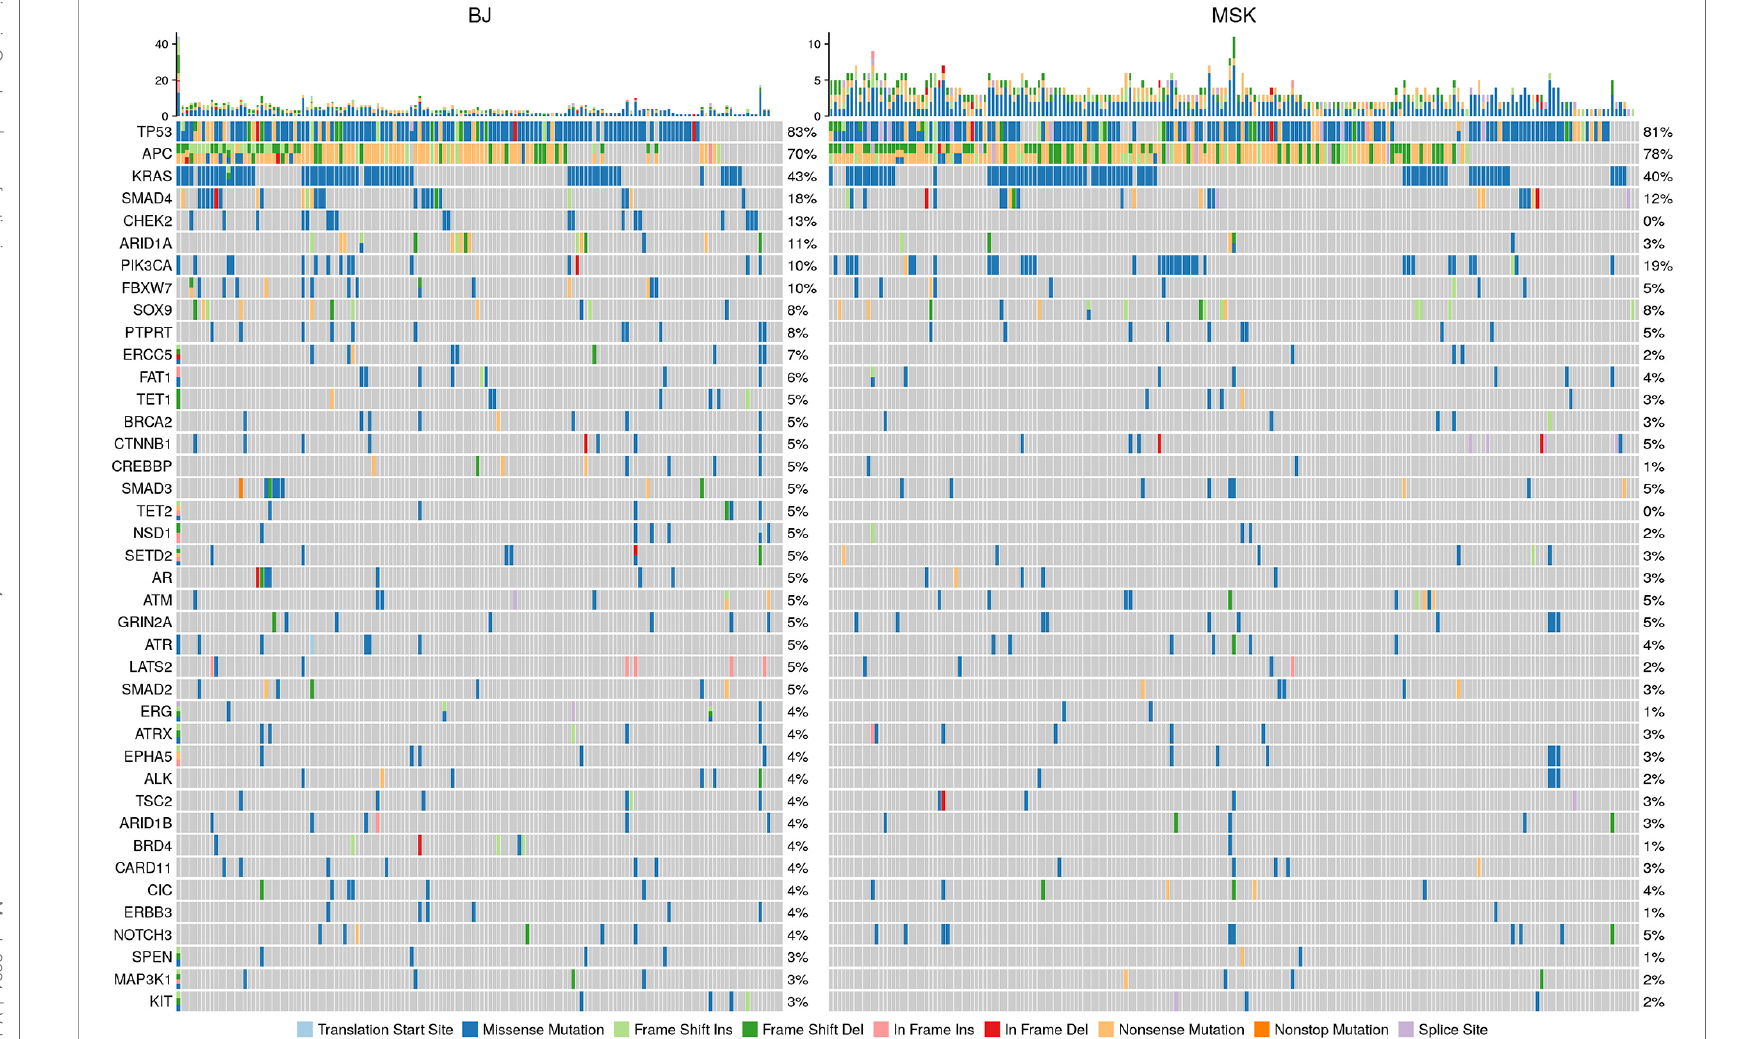
FIGURE 1 | Mutation spectrum comparison of our cohort with the 195 CRLM samples of the MSK data set (Yaeger et al. 2018). Our sequencing results were trimmed according to the standards and gene panel of the other dataset to maintain comparability. The distribution of genes and mutation were consistent between the two datasets, especially for the essential genes with high occurrences, such as TP53, KRAS, APC and